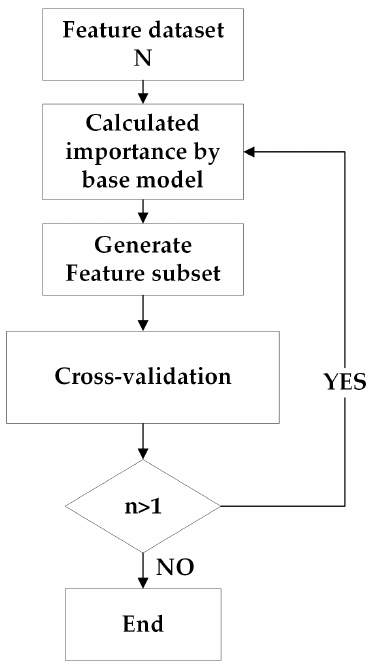
Figure 8. Flow chart of Recursive Feature Elimination (RFE).